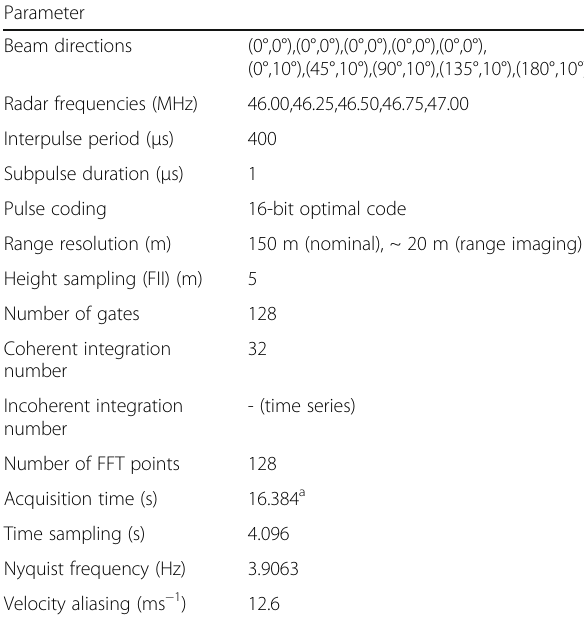
Table 1 MU radar parameters used during the ShUREX